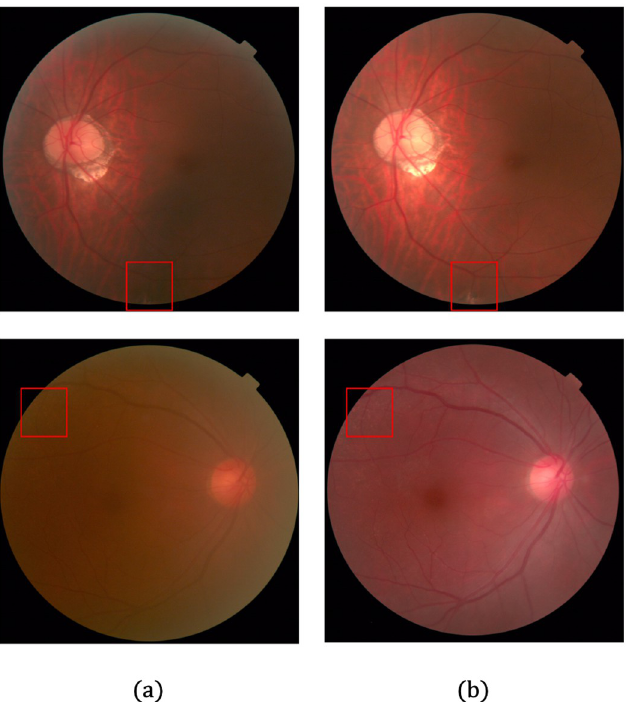
Fig 5. Examples of enabling diagnosis. Each row depicts images sampled from LQ and HQ samples, where lesions that were unnoticeable in LQ image are clarified in the corresponding HQ image. (a) LQ images. (b) HQ images corresponding to